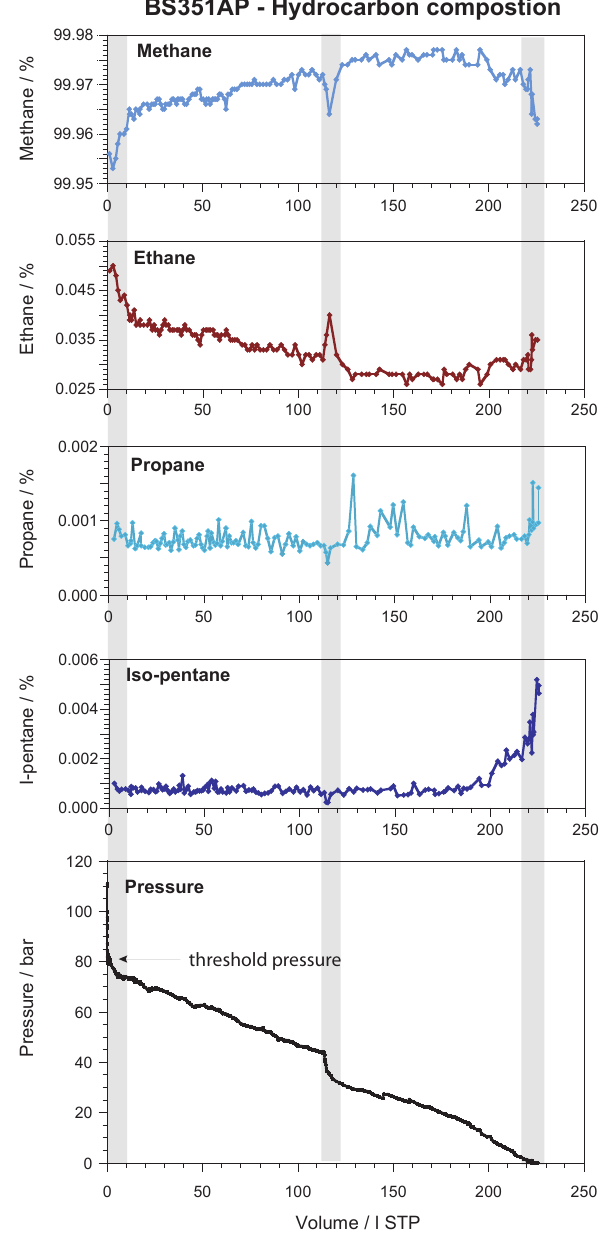
Fig. A2. Changes of gas composition (upper 4 panels) and pres- sure (lower panel) with increasing gas volume during the degassing of pressure core BS351AP. The gray-shaded boxes indicate areas of enhanced compositional changes, possibly due to free gas occur- rences (0–11l and 112–122l) and porewater degassing (215–226l). The threshold pressure defines the onset of gas hydrate decomposi- tion. See text for further